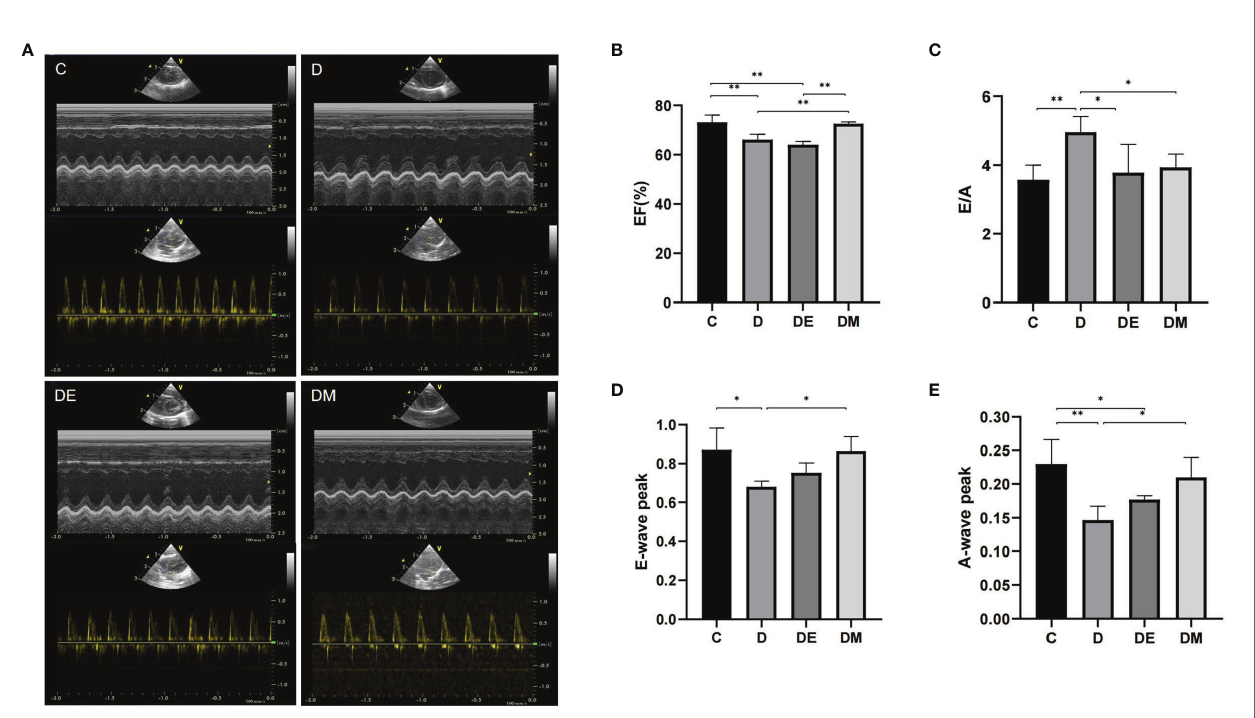
FIGURE 3 | Cardiac systolic and diastolic function after 8 weeks of aerobic exercise and MOTS-c treatment. (A) M-mode echocardiographic images and echocardiographic Doppler color fl ow images (B) Rats from groups D, DE had lower EF values compared with rats from groups C (p < 0.01) or DM (p < 0.01), with no signi fi cant differences in EF between rats from groups DM and C (p > 0.05). (C) The E/A ratio in rats from groups DE and DM were decreased compared with rats from group D (both p < 0.05), but was similar with those in group C (p > 0.05). (D) Rats from group DE had lower E-wave peak values compared with DM group (p < 0.05). (E) Values of A-wave peak in group DM were higher than that in group D (p < 0.05), with no differences between DM and C (p > 0.05). n = 10 rats in each group; *p < 0.05, **p < 0.01; C (control), D (diabetic), DE (diabetic+ exercise), DM (diabetic +